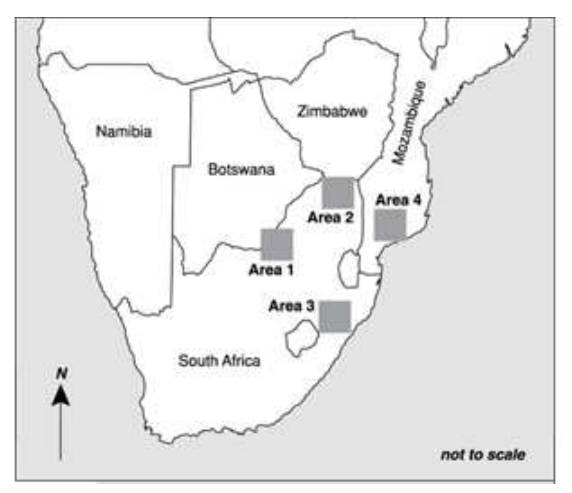
Fig. 2. Location of research areas: Area 1 Mantsie, Lehurutshe District, NorthWest Province, South Africa; Area 2 Khomele, Dzanani District, Limpopo Province, South Africa; Area 3 Mcitsheni, uThukela District, KwaZulu Natal Province, South Africa; Area 4 Nwadjahane, Manjacaze District, Gaza Province,